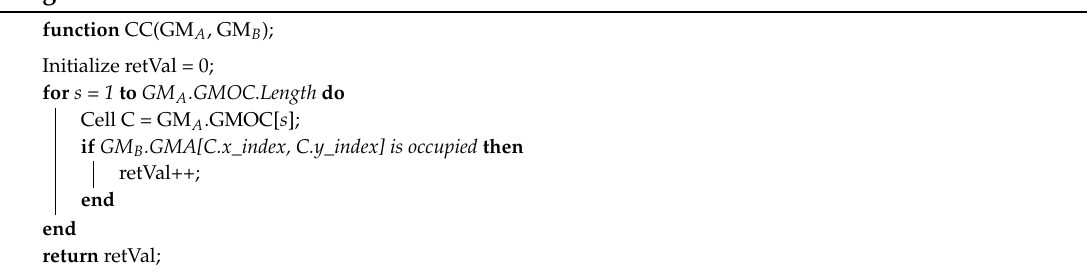
Algorithm 3: Pseudocode of